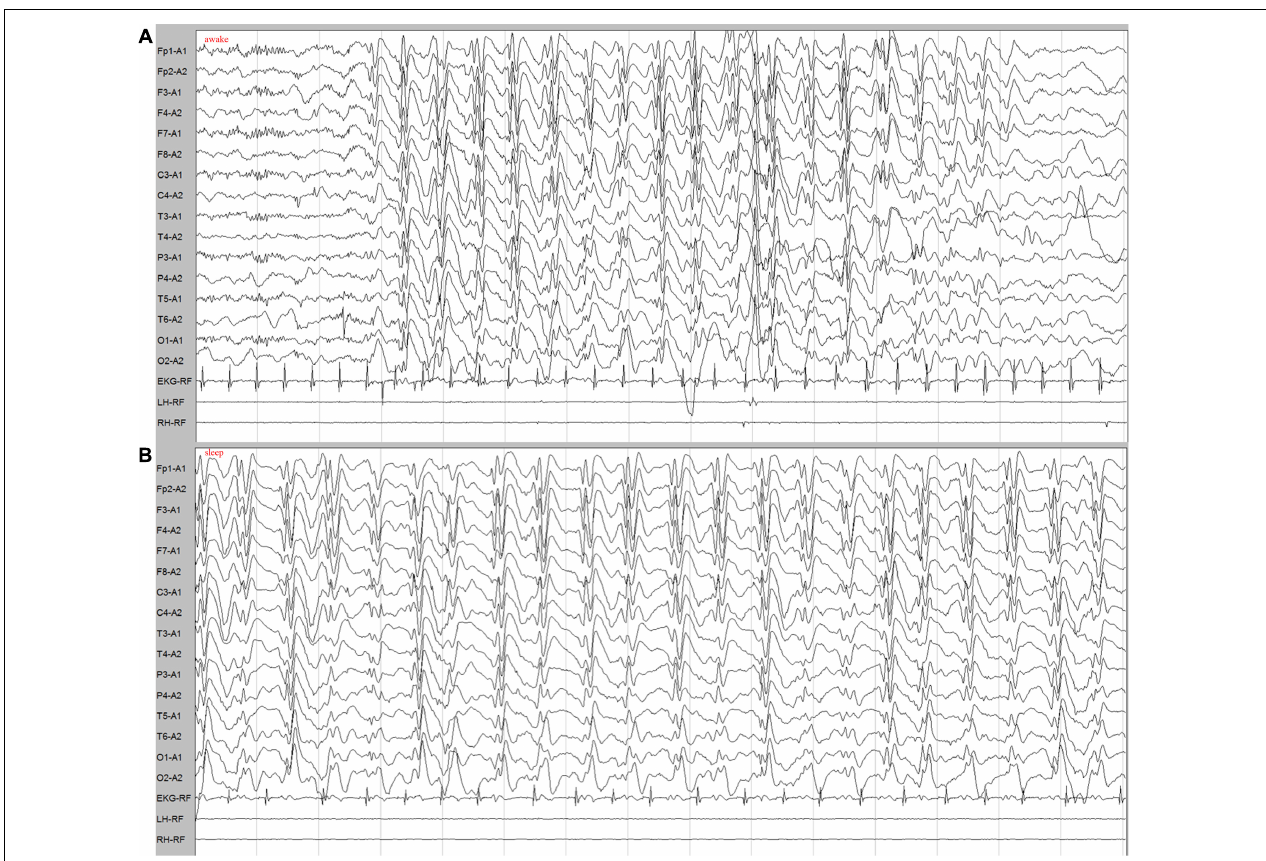
FIGURE 1 | EEG demonstrated generalized slow spike-and-wave complexes (1.6–2 Hz) in the patient. (A) Intermittent slow spike–wave discharges during awake. (B) Continuous spike–waves during